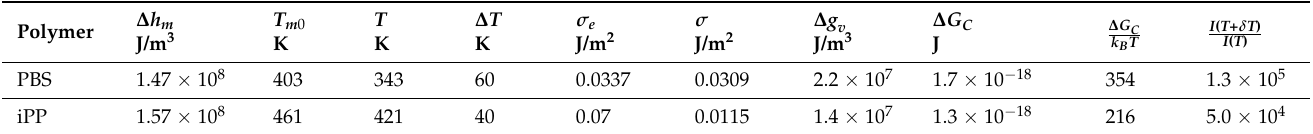
in PBS and iPP at δ T = − 1 I ( T )